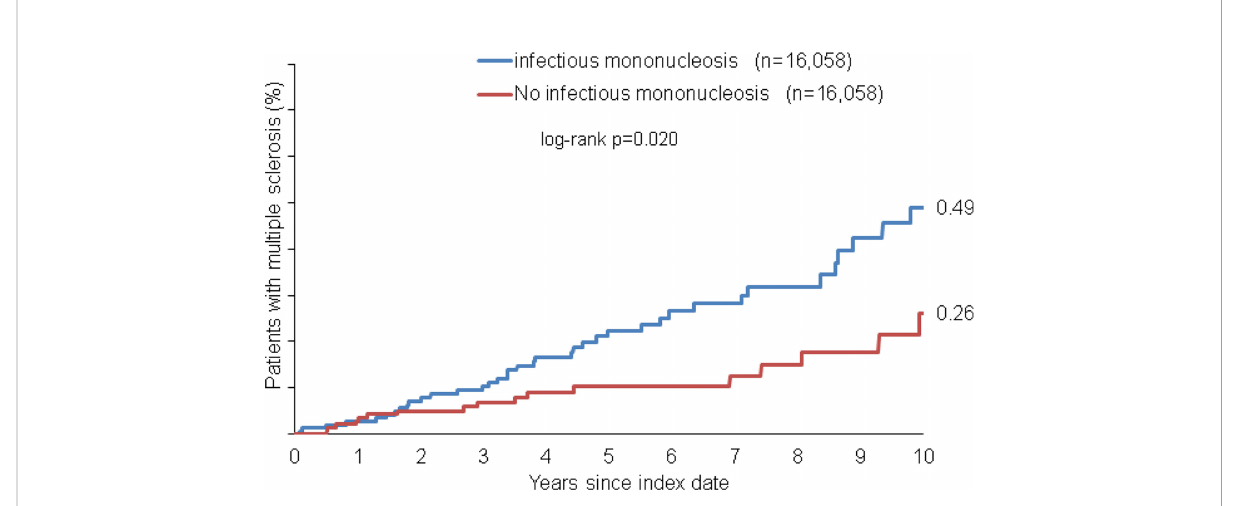
FIGURE 2 Kaplan-Meier curves regarding the incidence of multiple sclerosis diagnosis in patients with and without infectious mononucleosis.